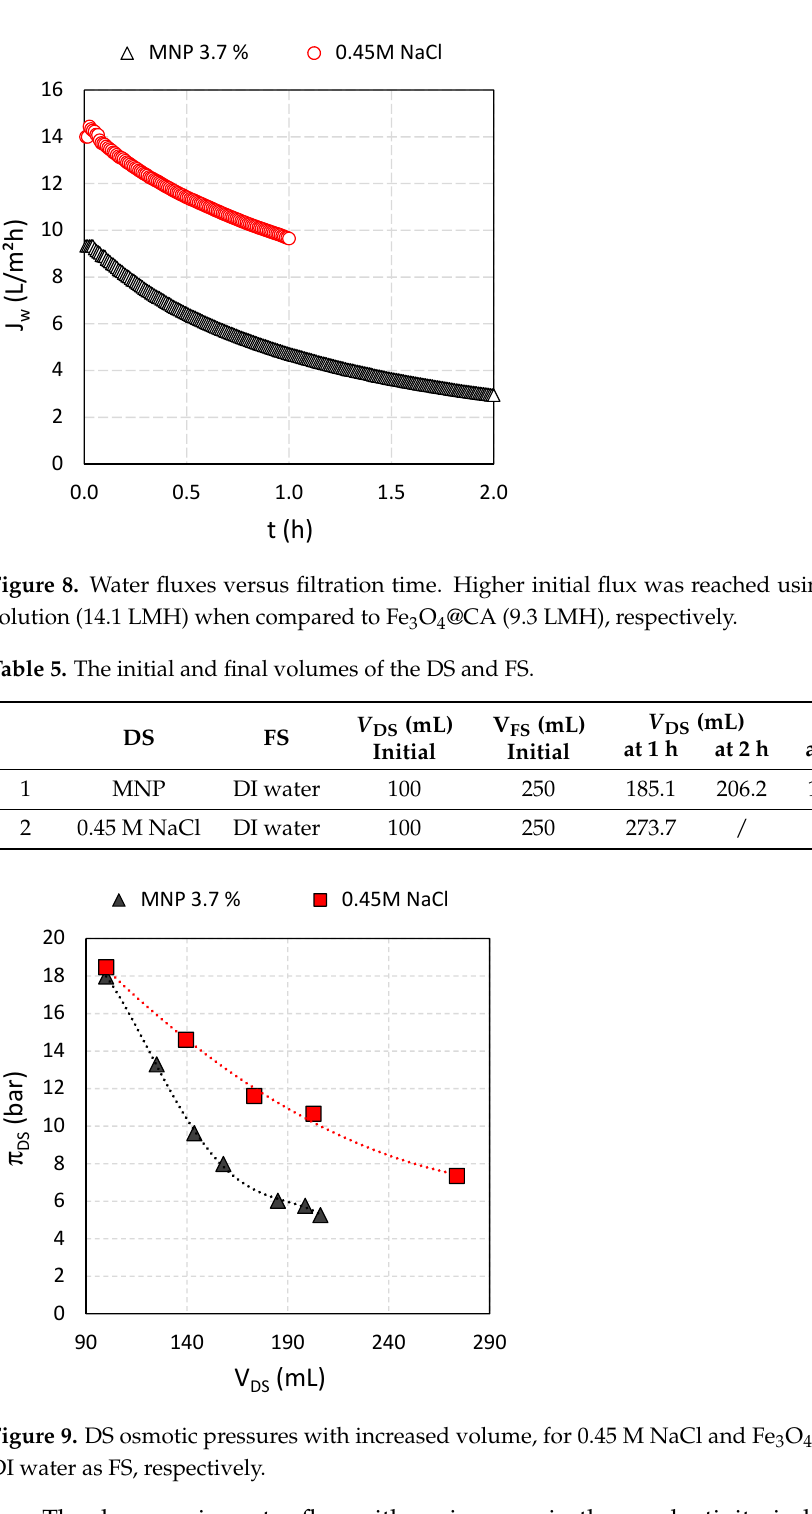
Figure 9. DS osmotic pressures with increased volume, for 0.45 M NaCl and Fe 3 O 4 @CA as DS and DI water as FS, respectively.